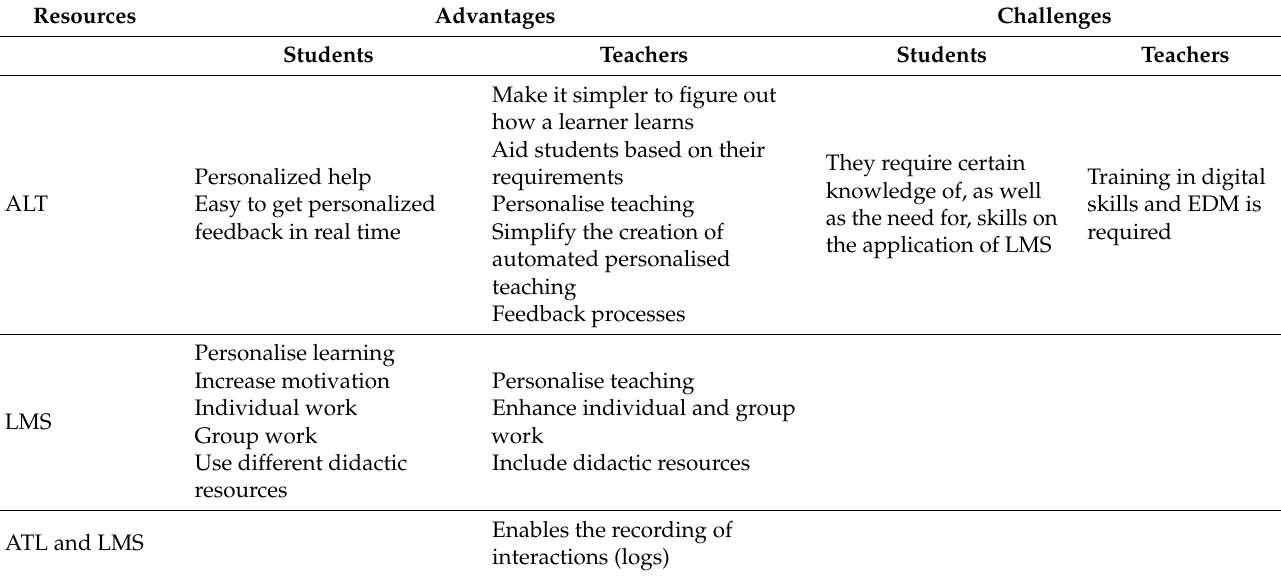
Figure 1. Teaching-learning process in 21st century society. Table 1. Summary of the benefits and drawbacks when using digital resources in the teaching–learning process.